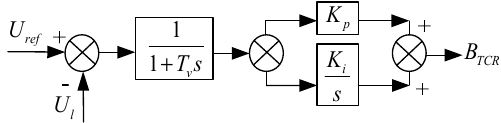
Figure 6. Simplified control block diagram of SVC.